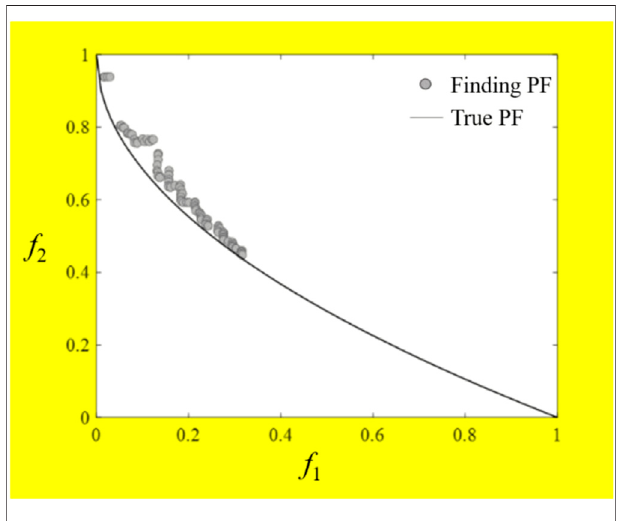
FIGURE 1 | Clustering phenomenon of MOEA/D.